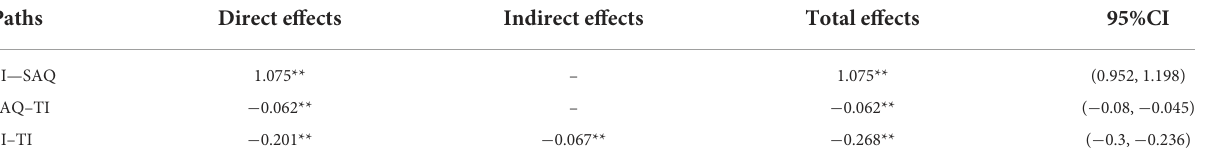
TABLE 5 Results of mediation